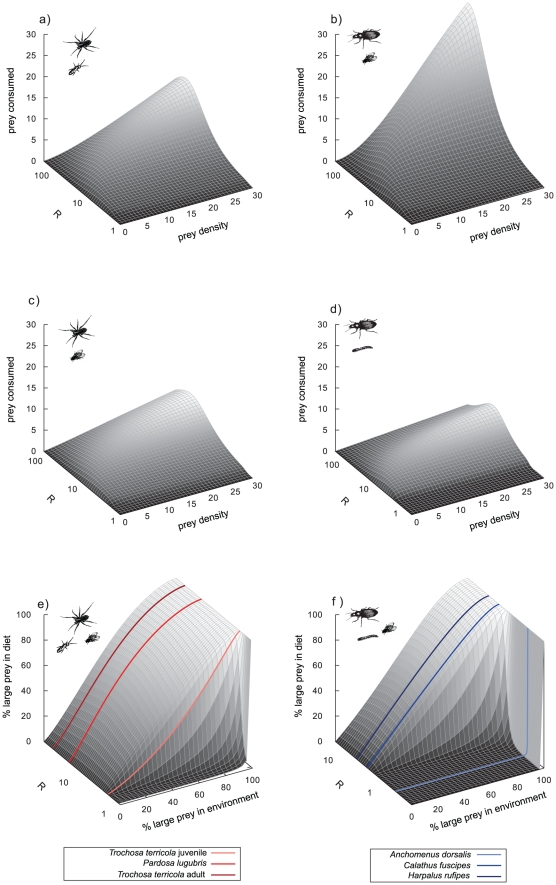
Single prey functional responses as a function of predator-prey body mass ratios from previous study[18] for the following predator-prey combinations: a) wolf spiders – Drosophila, b) ground beetles – Alphitobius, c) wolf – spiders – Heteromurus and, d) ground beetles – Drosophila.Parameters applied for these models are given in Table 1. Combining of the single-prey functional responses for one large and one small prey allowed calculating predictions of the allometric functional response models for the two-prey preference experiment with e) spiders (body-mass range from 1 to 200 mg) with Drosophila as large prey and Heteromurus as small prey, and f) beetles (body-mass range from 1 to 600 mg) with Drosophila as small and Alphitobius larvae as large prey. The coloured lines indicate the six species (i.e., body size classes) that were tested empirically in this study (see Fig. 4). Note the difference between absolute consumption in plots a–d while 3 e and f show relative consumption on the x- and z-axes. Note that for the two-prey plots (3 e and f) the predator-prey body-mass ratio (R) on the y-axes relates to the ratio between the predator and its larger prey.